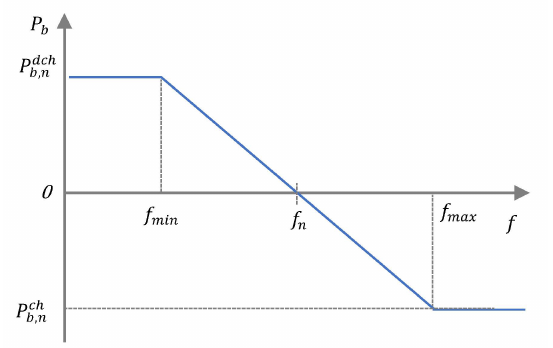
Figure 5. Action of the BESS for the primary frequency regulation service in the absence of the